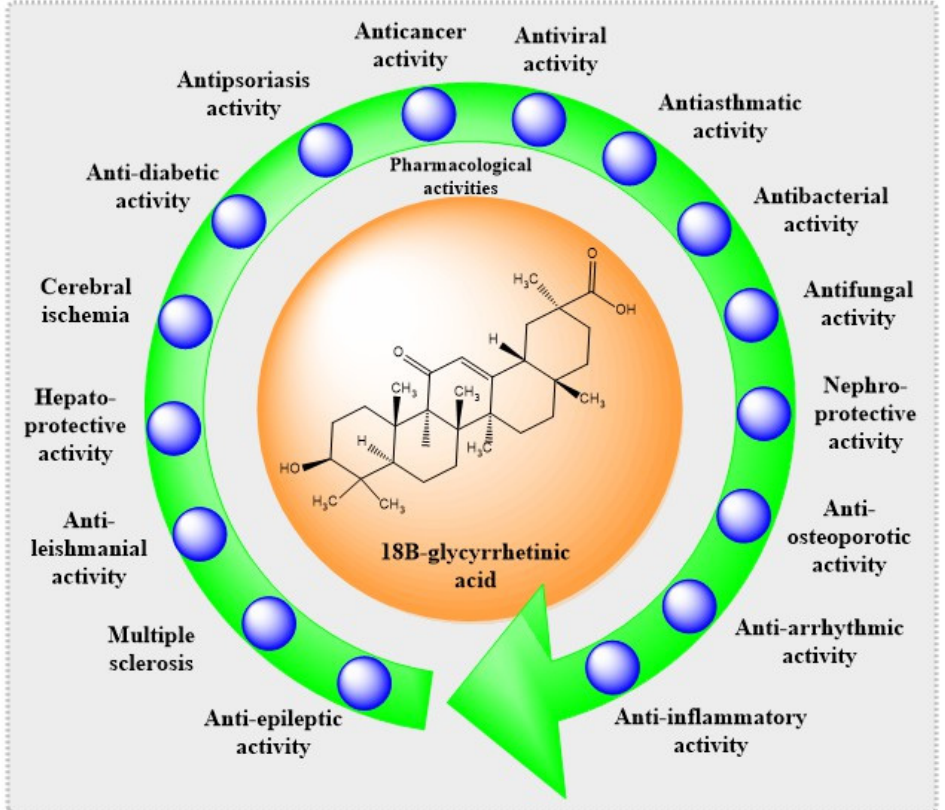
Figure 2. The pharmacological activities of 18 β -glycyrrhetinic acid.